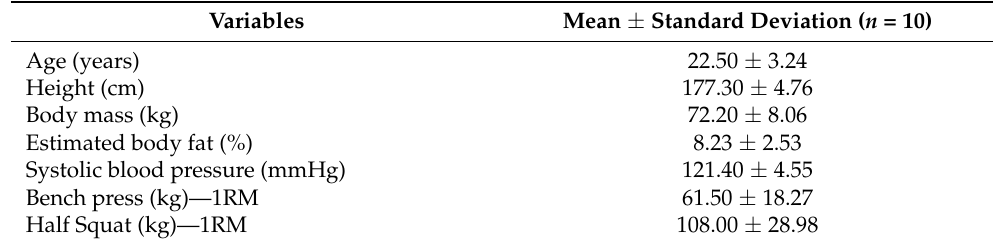
Table 1. Characteristics of the